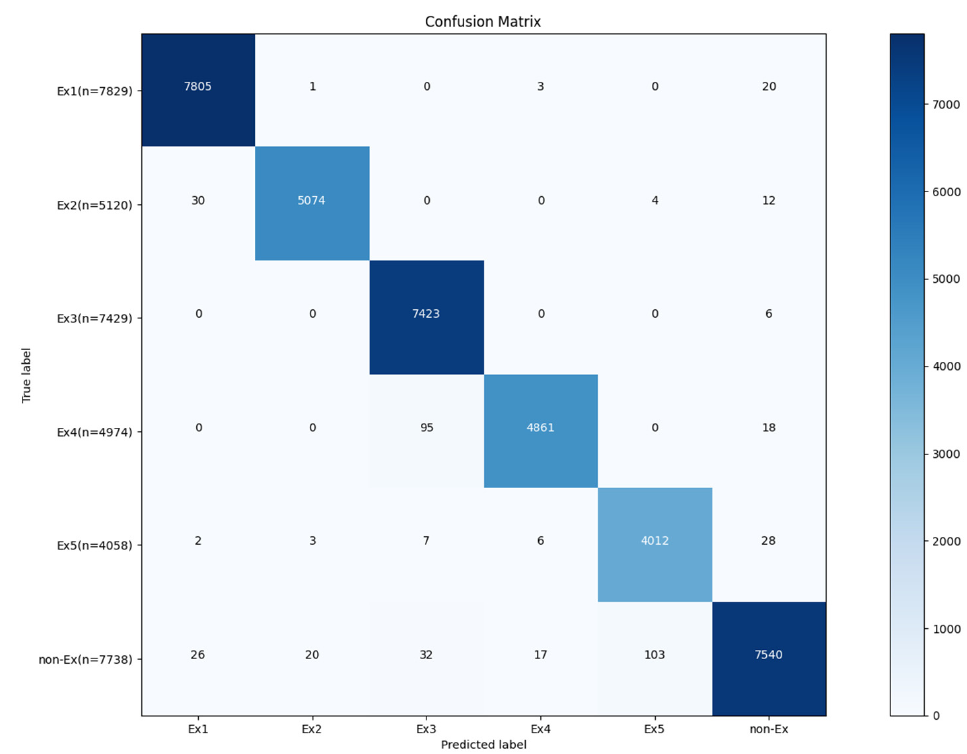
Figure A9. Confusion matrix for IMU and joint position input models.